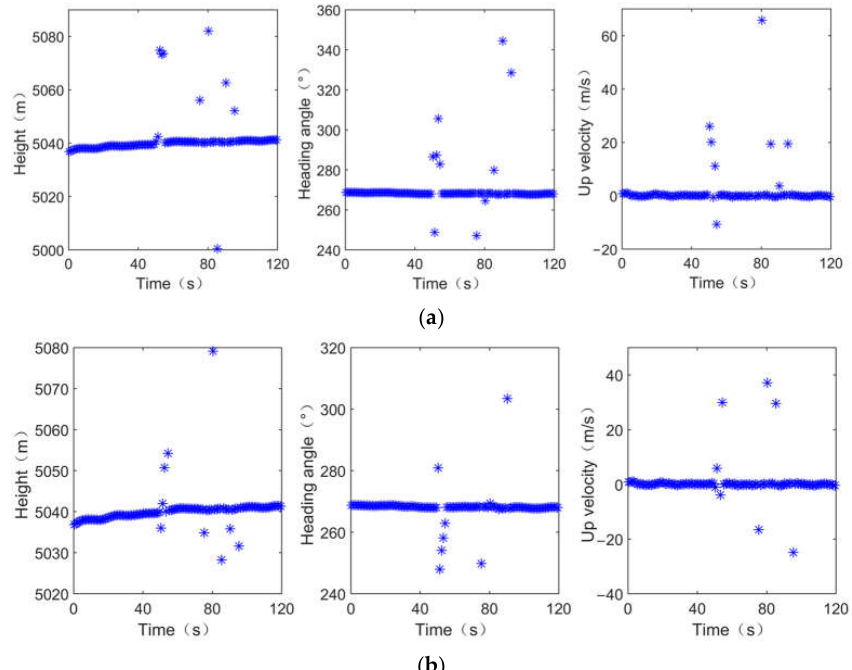
Figure 6. Data from GNSS after adding outliers. ( a ) Data from GNSS in left node after adding outli- ers; ( b ) Data from GNSS in right node after adding outliers. ( b ) Data from GNSS in right node after adding